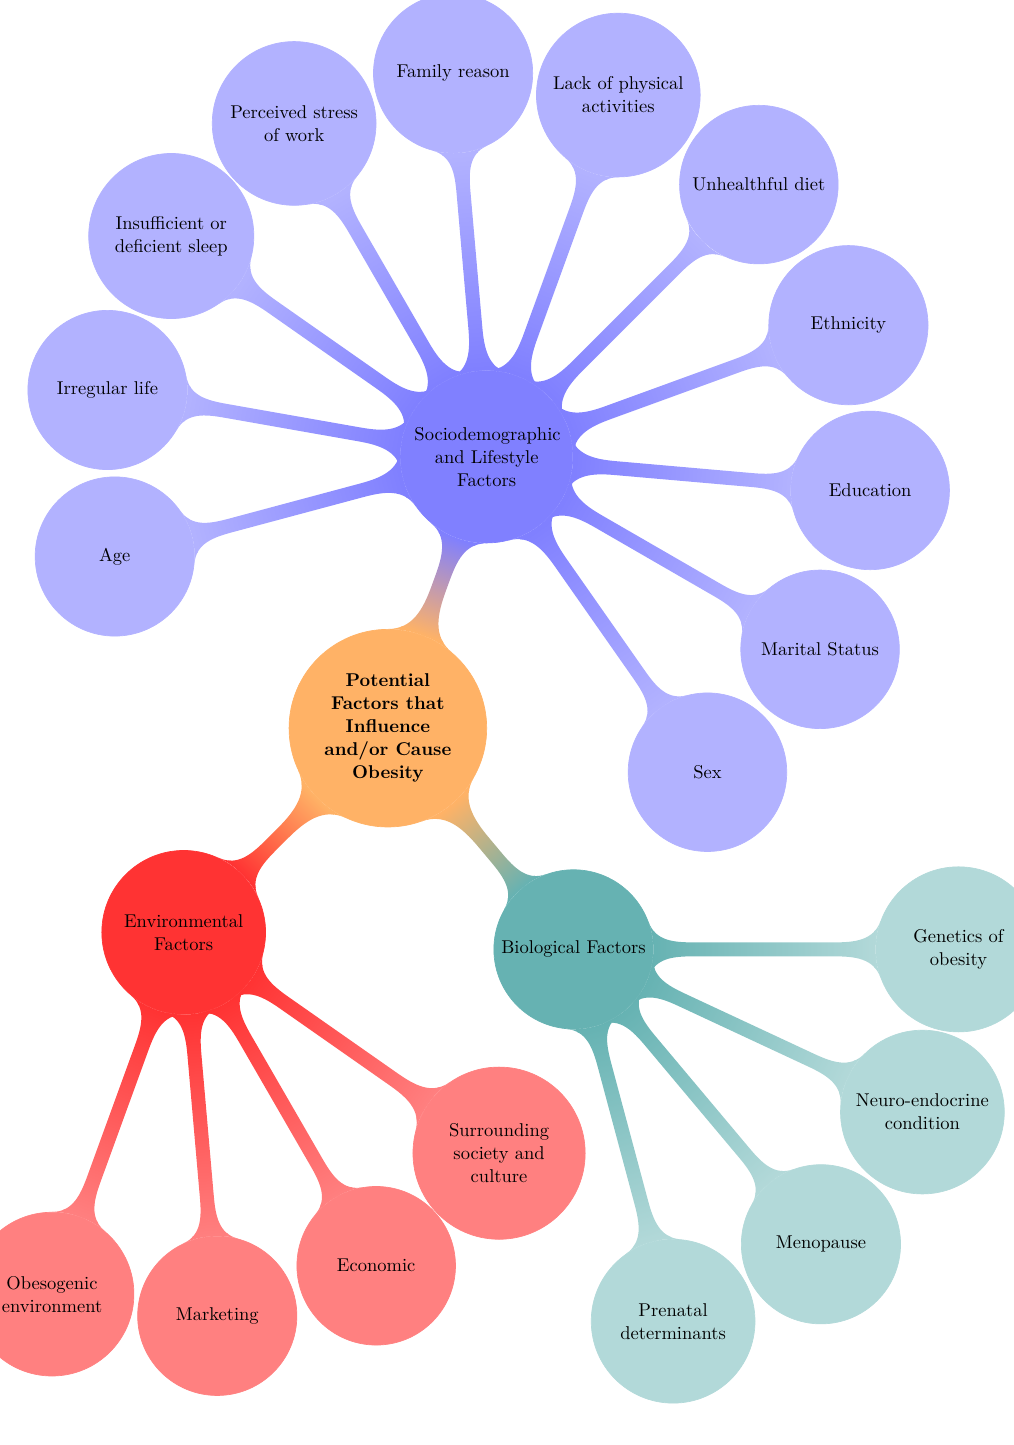
Figure 1. Explored risk elements of overweight or obesity in